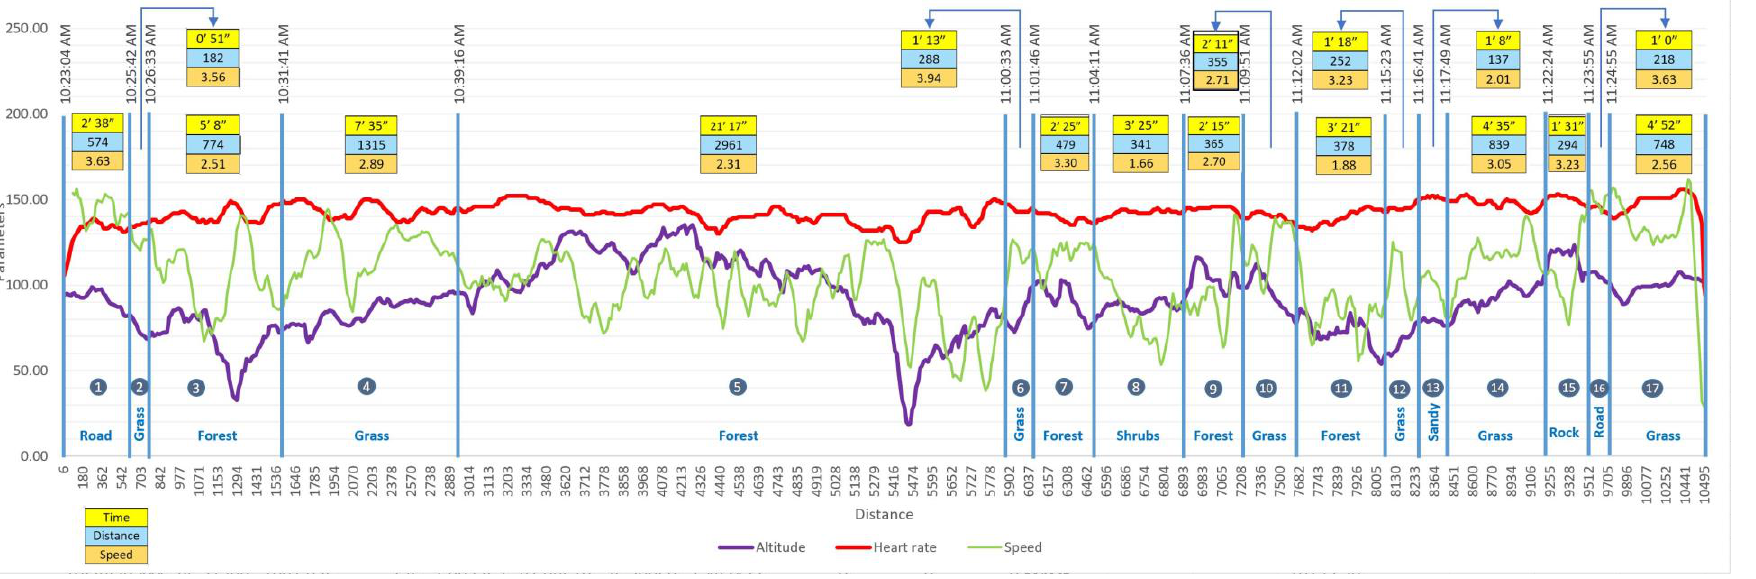
Figure 4. Movement observations corresponded to the path illustrated in Figure 2, including altitude, heart rate, speed, as well as the land